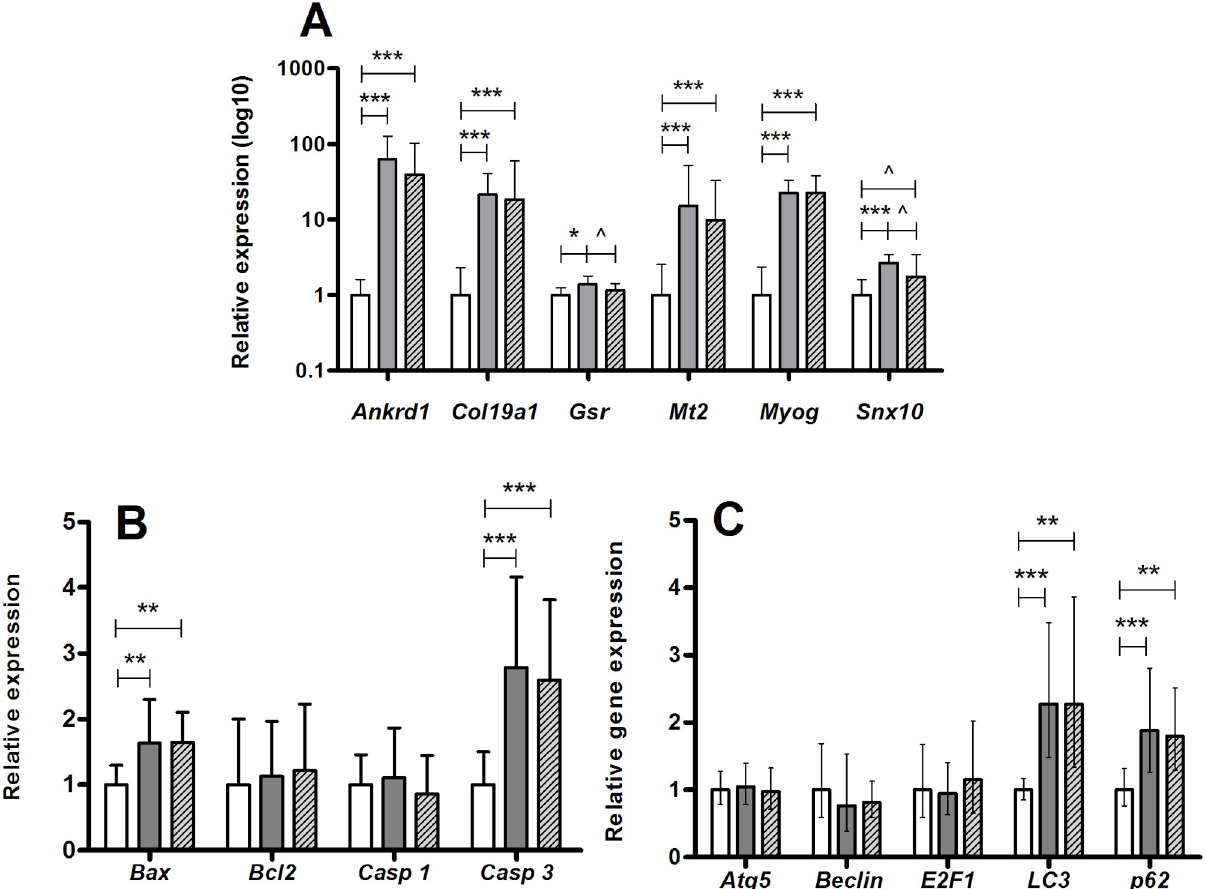
Fig 6. Gene expression profile in skeletal muscle. The graphics show the fold change in transcript levels in non-treated SOD1G93A muscles (gray bars) and 5-FU treated SOD1G93A muscles (dashed bars) compared with their respective wild-type littermates (white bars) at 105 days of age. (A) Fold change in the transcript levels of Ankrd1, Col19a1, Gsr, Mt2, Myog and SNx10. (B) Fold change in the expression of the apoptotic regulators Bax,Blc2, Casp1 and Casp3. (C) Transcript levels of the autophagy mediator´s genes Atg5, Beclin, E2F1, LC3, and p62. Data are shown as mean values ± SEM. � p < 0.05; �� p < 0.001; ^ p < 0.1 (tendency).